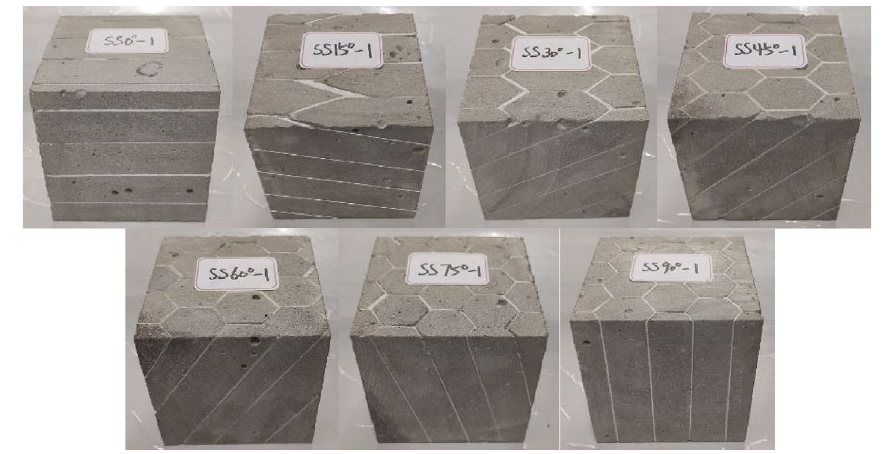
Figure 2: Similar-material samples of the columnar jointed rock masses with di ff erent dip angles.